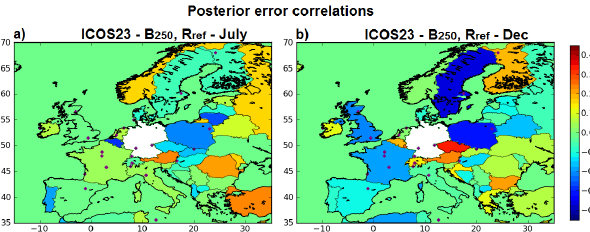
Figure 6. Correlations of the posterior uncertainties in a 2-week- mean NEE between Germany and the other European countries in July (a) and December (b) from the reference inversions with ICOS23. Germany is masked in white. Red/blue colors indicate rel- atively high positive/negative correlations (with min = − 0 . 45 and max = 0.45 in the color scale).